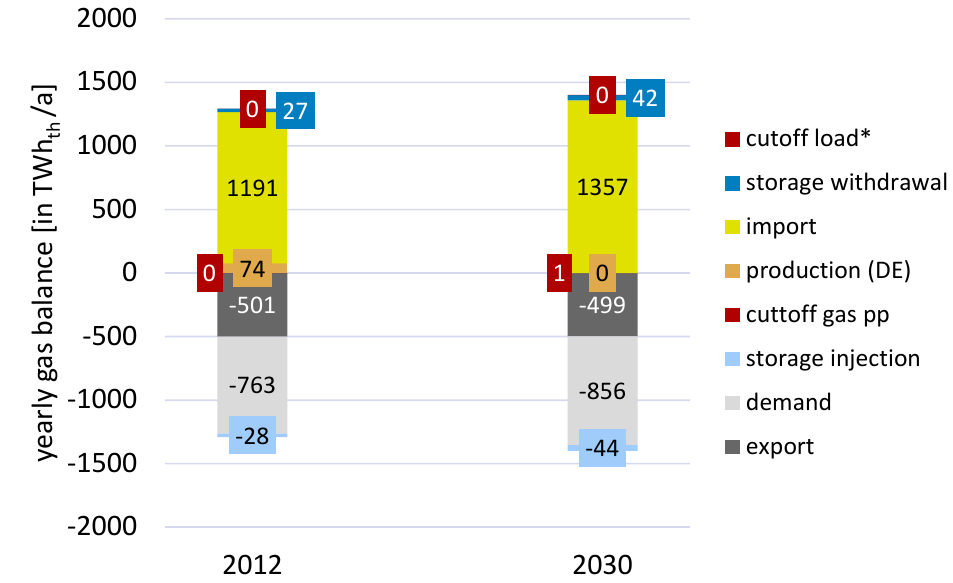
Figure 12. Results of GAMAMOD-DE for yearly gas balances in 2012 and 2030.